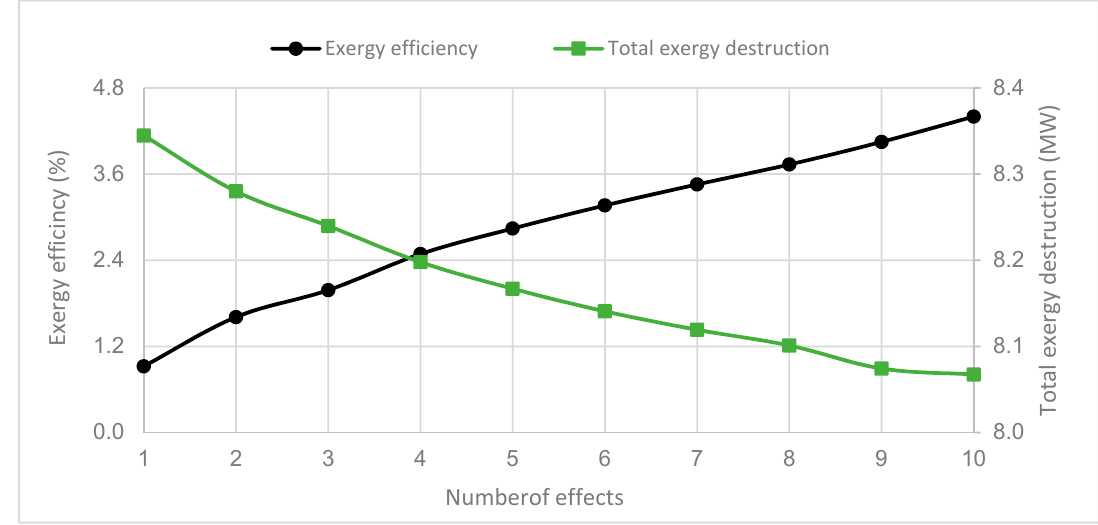
Figure 9. Exergy efficiency and total exergy destruction versus number of effects.